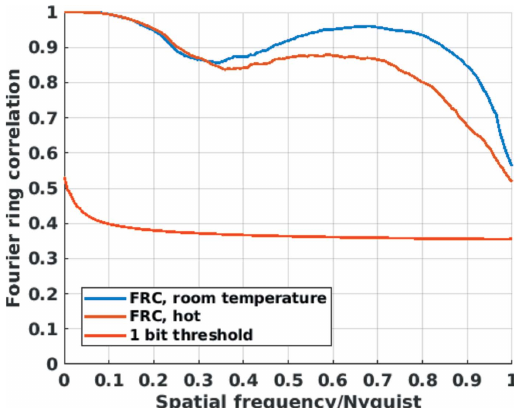
Figure 7 Fourier ring correlation curves of 2D projections of the nanoporous gold sample. Between two projections acquired at a nominal temperature of 50 (cid:2) C (room temperature) and between two projections acquired at a high temperature of 600 (cid:2) C (hot). Pixel size: 19.4 nm.